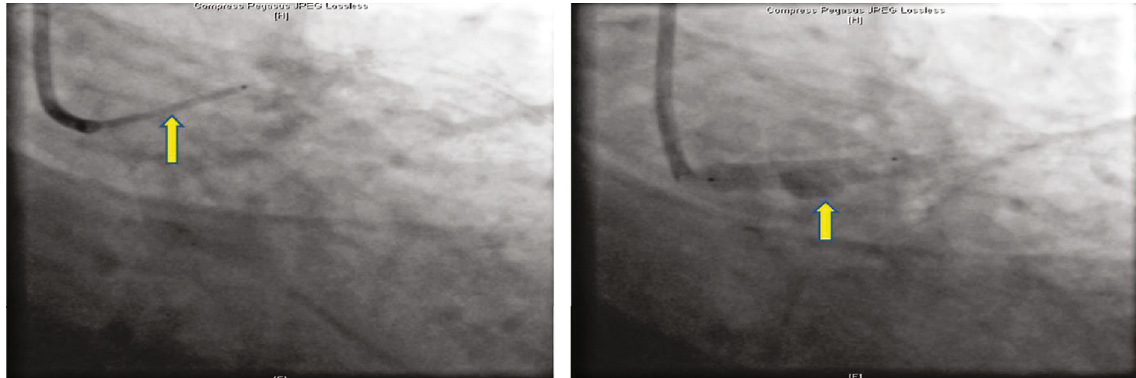
Figure 4: Positioning and deploying the stent in the left main coronary artery.